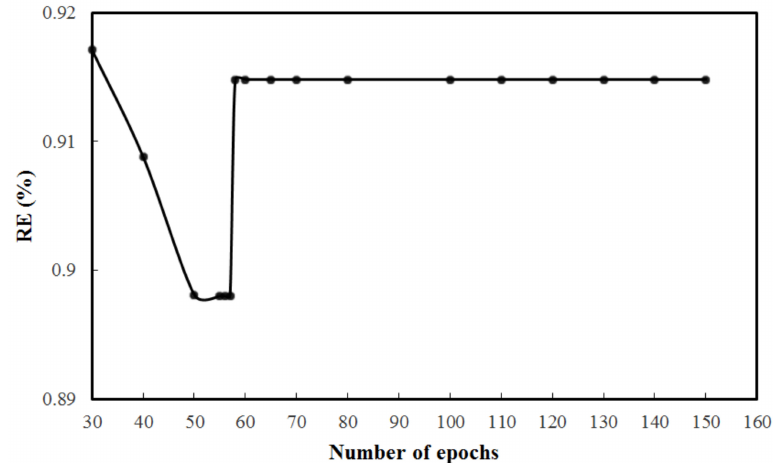
Figure 8. Training of BP neural